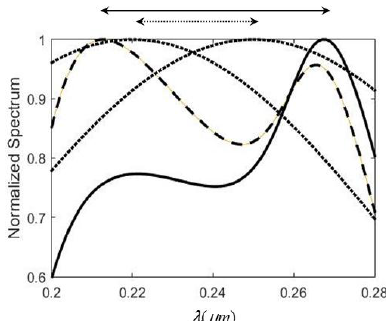
Figure 5. The normalized spectrum of I ( i ) (λ) (dotted line), I ( r ) (λ) (solid line), and R (λ) (dashed line) for three incremental λ c . ( a ) λ c = 0.307 µm; ( b ) λ c = 0.310 µm; ( c ) λ c = 0.312 µm. The shift of the spectrum maximum is indicated by the arrows on the top of the figure; ( d ) The spectral shift amplification (SSA) effect with Ag. The SSA factor is 6.5.